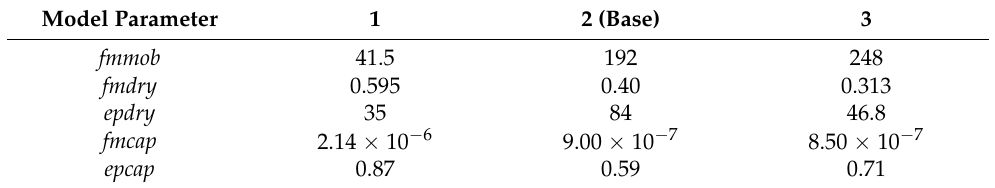
Table 4. Foam model parameters used in the sensitivity study. Foam model 2 was used in the base case. Model